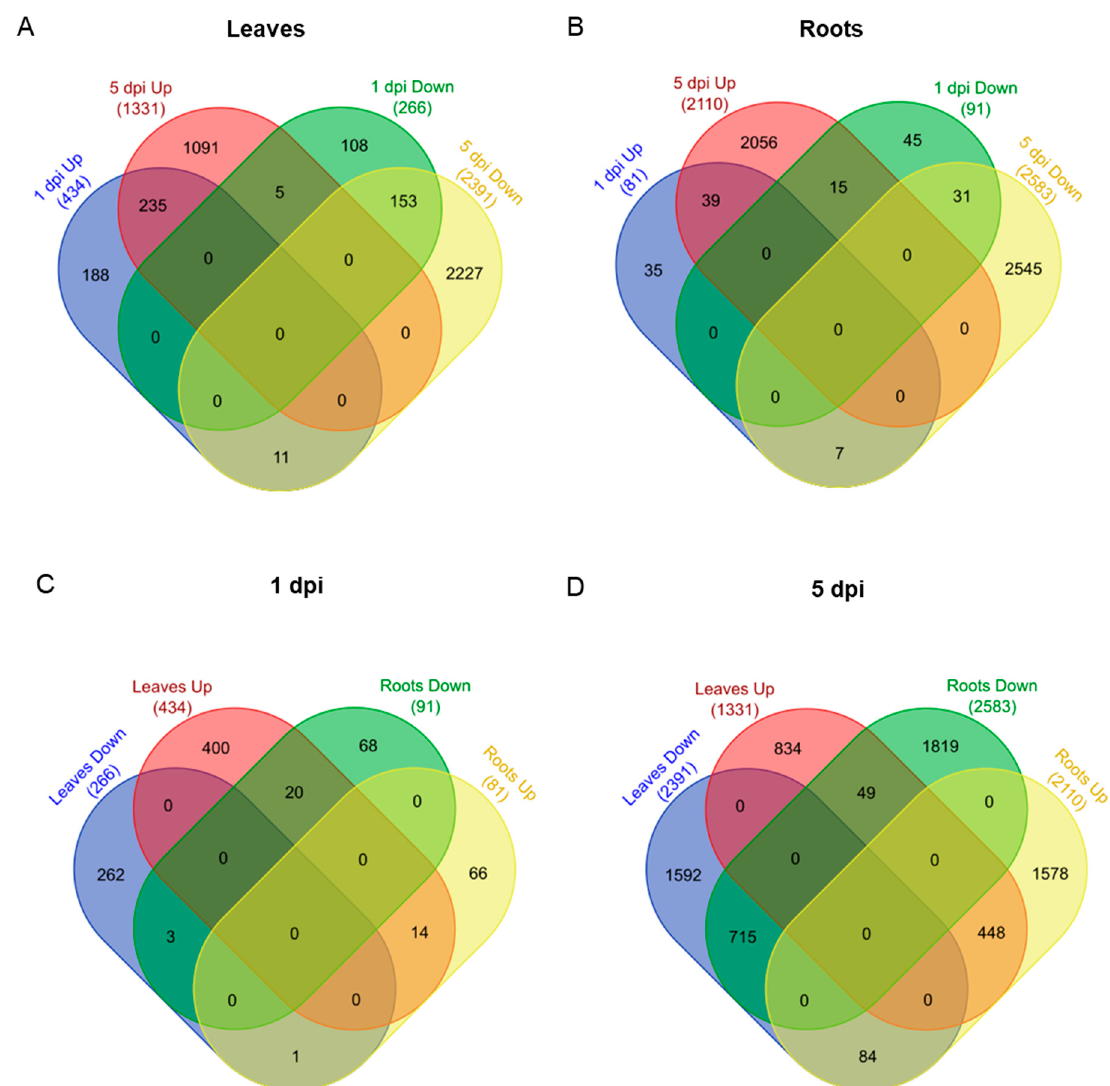
Figure 3. Venn diagrams of differentially expressed genes (DEGs) in Mp708 plants. The number of DEGs are indicated in parenthesis. DEGs in each tissue. ( A ) Leaves and ( B ) roots or at each time point: ( C ) 1 dpi and ( D ) 5 dpi. Up: upregulated; Down: downregulated.